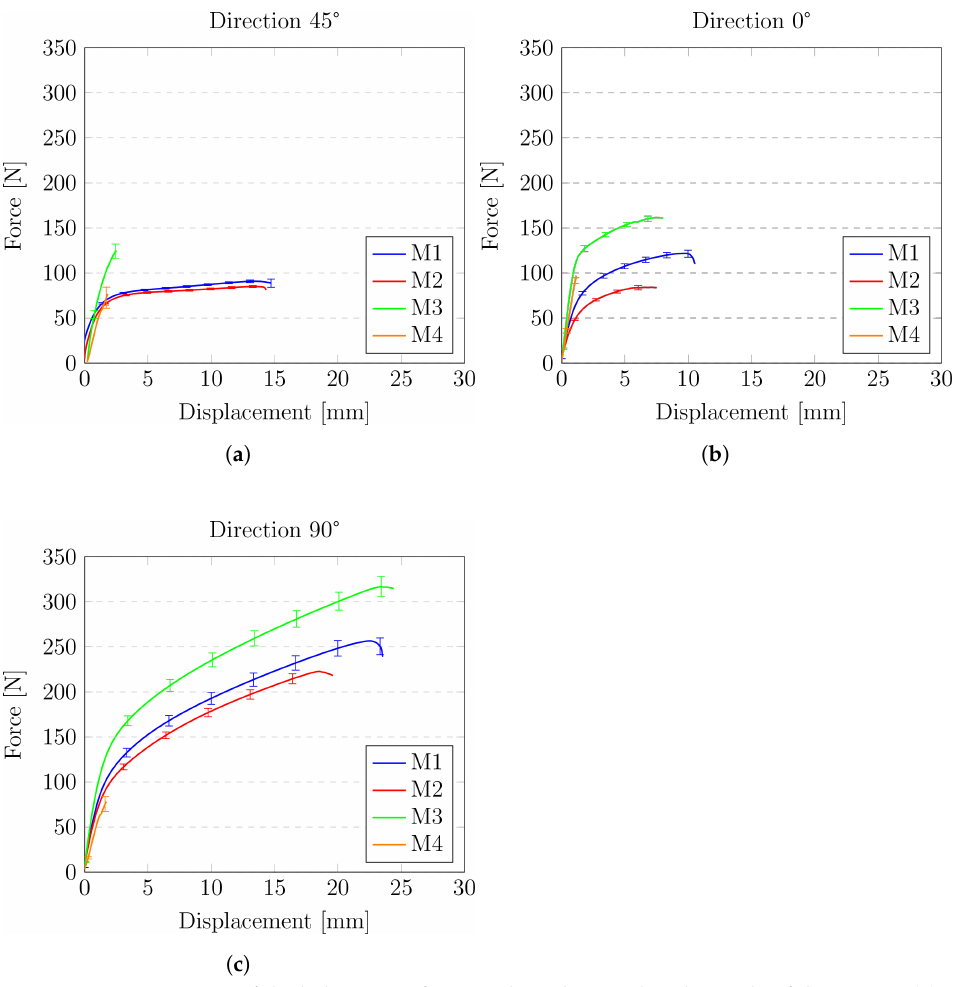
Figure 17. Comparison of the behaviour of materials with regard to the angle of the matrix: ( a ) 45